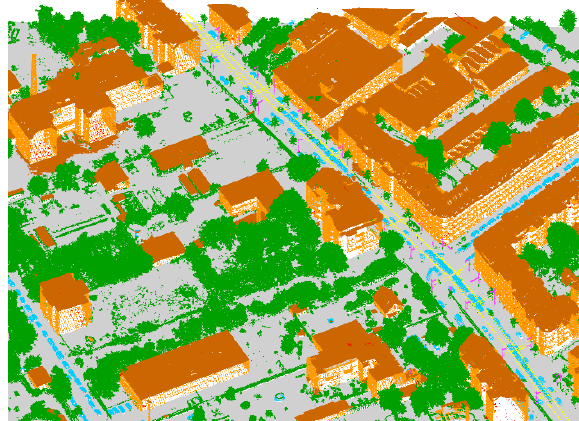
Figure 6 . Classification results of an ALS 3D point cloud using KPConv with height above ground and input classes as priors.